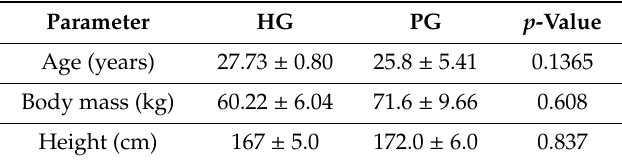
Table 1. Anthropometric data of the subjects and p-value of relationship between the healthy group (HG) and ACLR group (PG). Values stated as mean ± standard